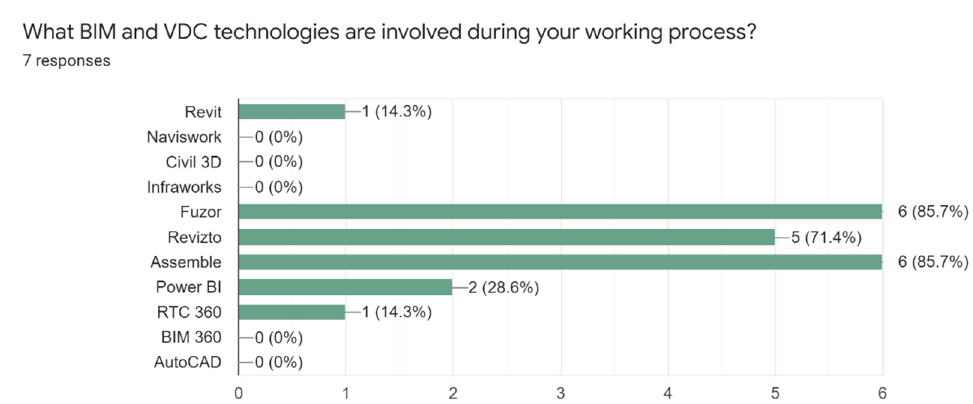
Figure 3. Summary of BIM and VDC technologies involved during working process.